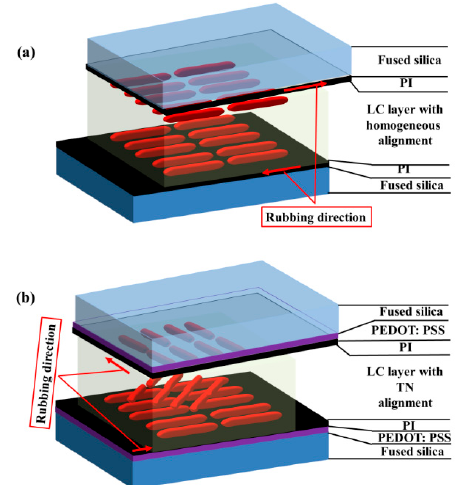
Figure 1. Schematic illustration of device structures for ( a ) a homogeneously aligned liquid crystal (LC) cell to carry out the optical constant measurement of both types of LC and ( b ) a twisted nematic (TN)-LC phase shifter with pristine poly(3,4-ethylenedioxythiophene):polystyrenesulfonate) (PEDOT: PSS) as transparent electrodes.